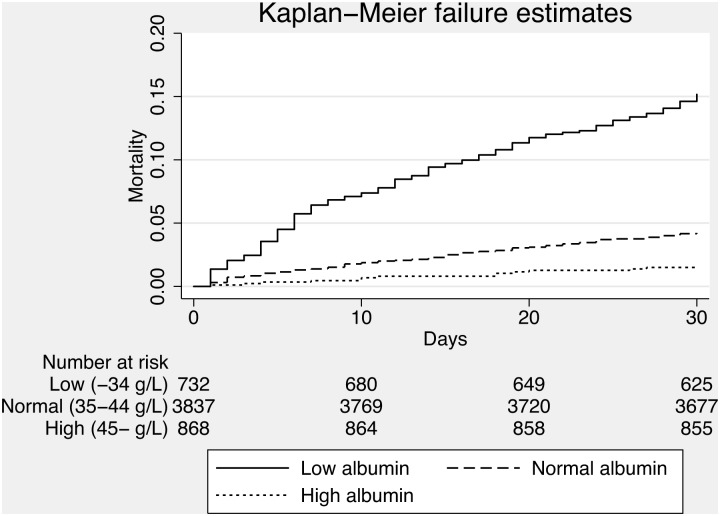
Kaplan-Meier failure plot of mortality of each of the three levels of albuminemia.